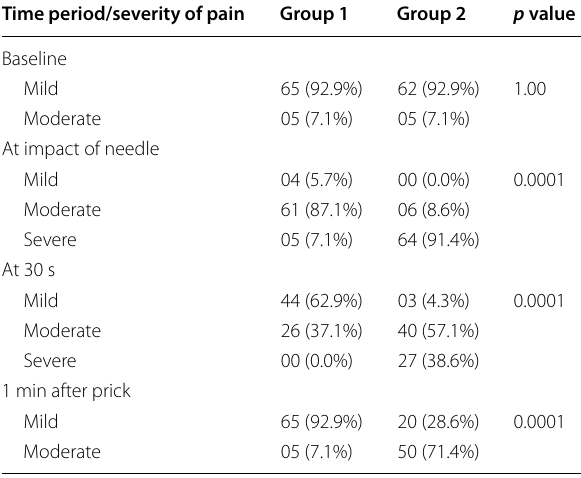
Table 3 Comparison of severity of pain between the groups